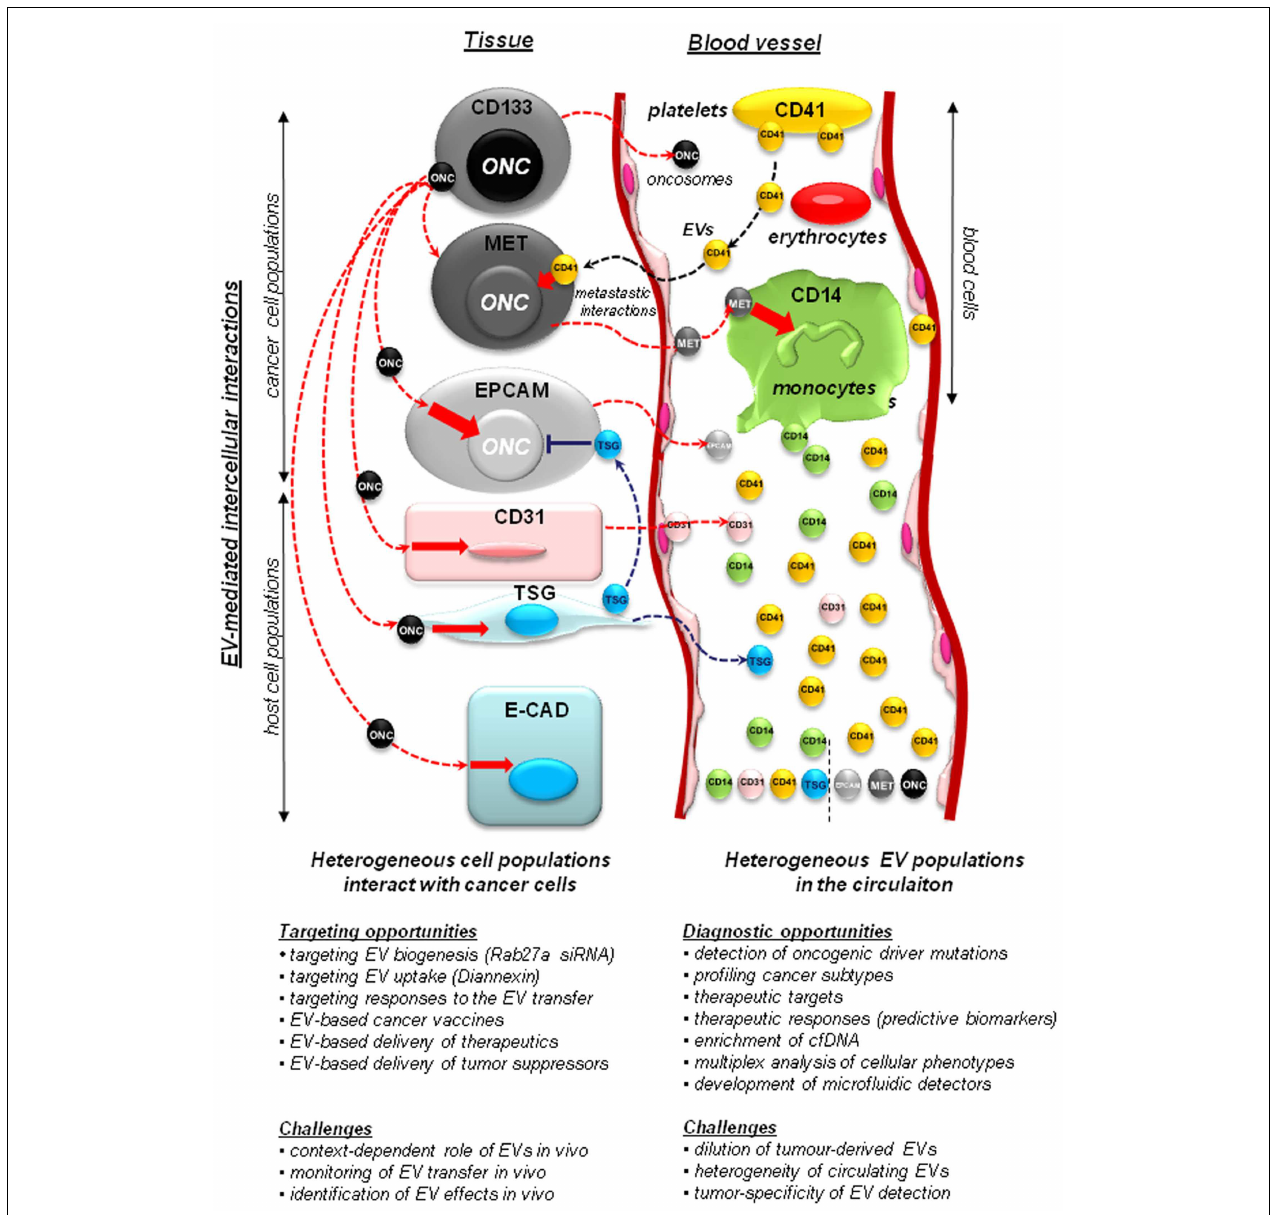
phenotype, as well as (in some cases) acquisition of tumorigenic properties; (ii) transfer of tumor suppressors (TSG), such as PTEN between cells, with a possible impact on negative control of cellular transformation; (iii) transfer of MET receptors from metastatic cancer cells to myeloid cells (CD11b + ) to modulate metastatic niche effects; (iv) contribution of platelet-derived EVs (CD41 + ) to the metastatic phenotype of cancer cells, and several other effects; (v) shedding of EVs by activated endothelium (CD31 + ).While tumor-derived EVs constitute a minority within the pool of particles circulating in plasma, they can be detected for diagnostic purposes.The diagnostic and therapeutic opportunities, and challenges associated with studies on cellular vesiculation are described in the text in